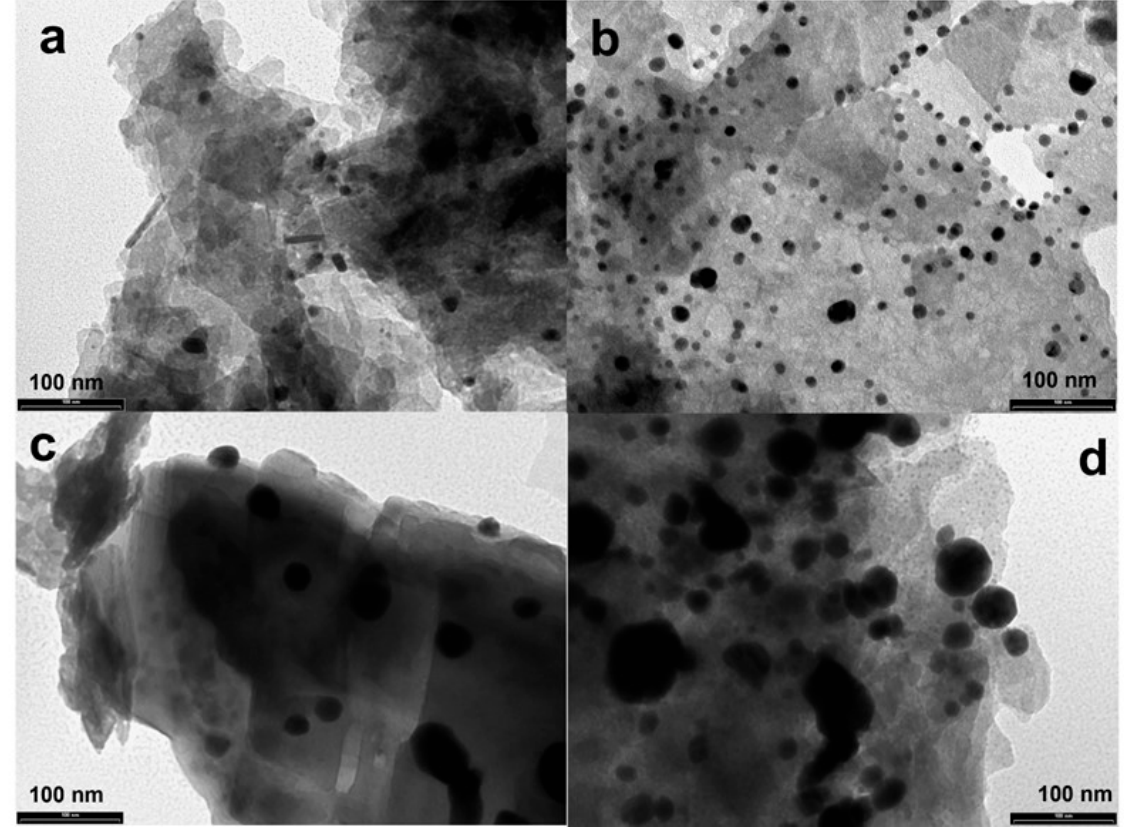
Figure 5. TEM images of US50B ( a ), US100B ( b ), US50C ( c ), and US100C ( d